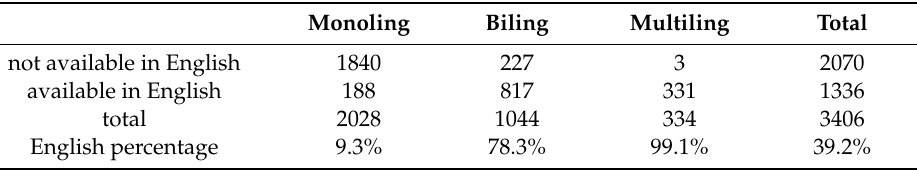
Table A32. English language availability (lv).